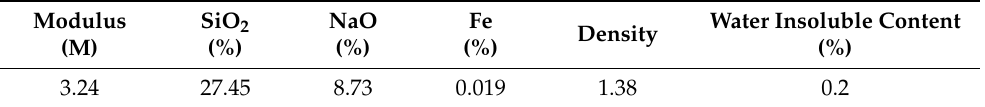
Table 3. Main parameters of sodium silicate.